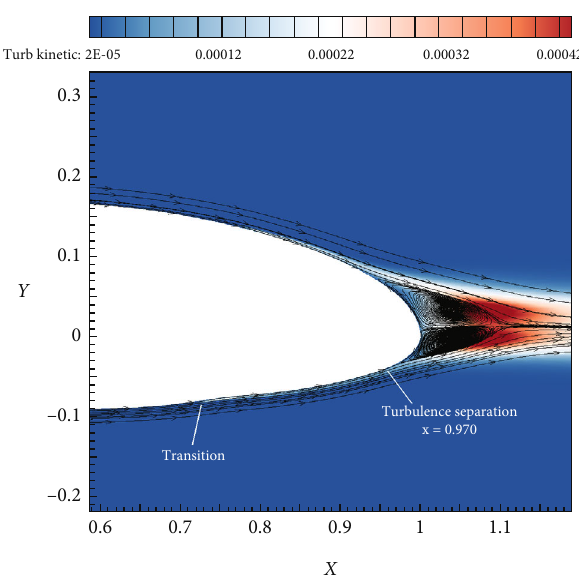
Figure 28: Turbulent kinetic energy distribution of DBLN-526 airfoil ( Re = 0 : 8 E 6 , α = 0 °